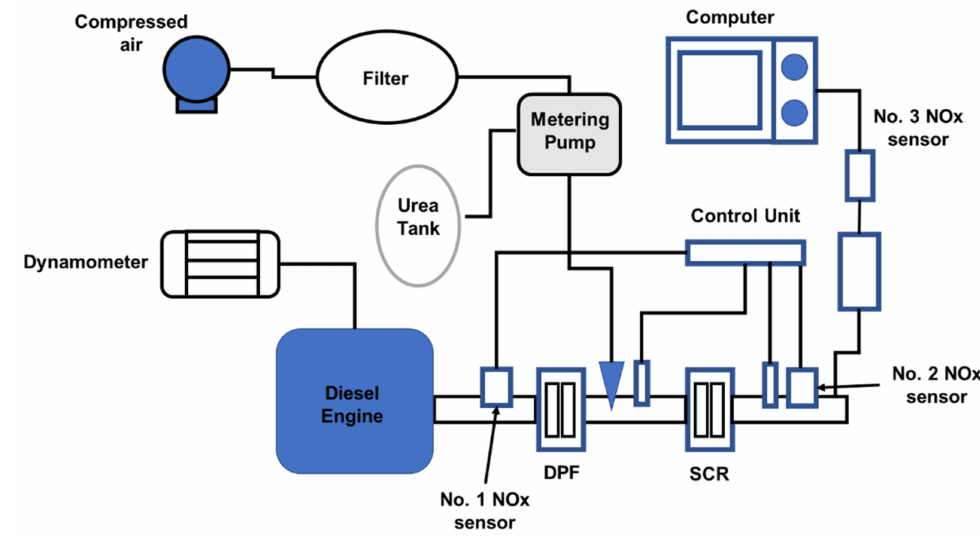
Figure 5. Schematic diagram of the SCR aftertreatment system for an 1800 cc diesel engine